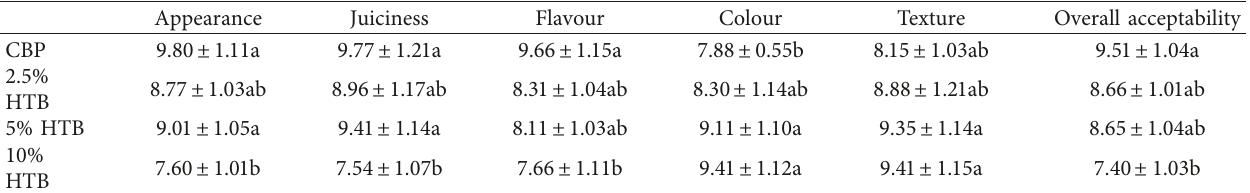
Values followed by different letters in each column differ Table 5: Sensory properties of fresh beef patties prepared with different concentrations of husk tomatoes (mean values ± SD).